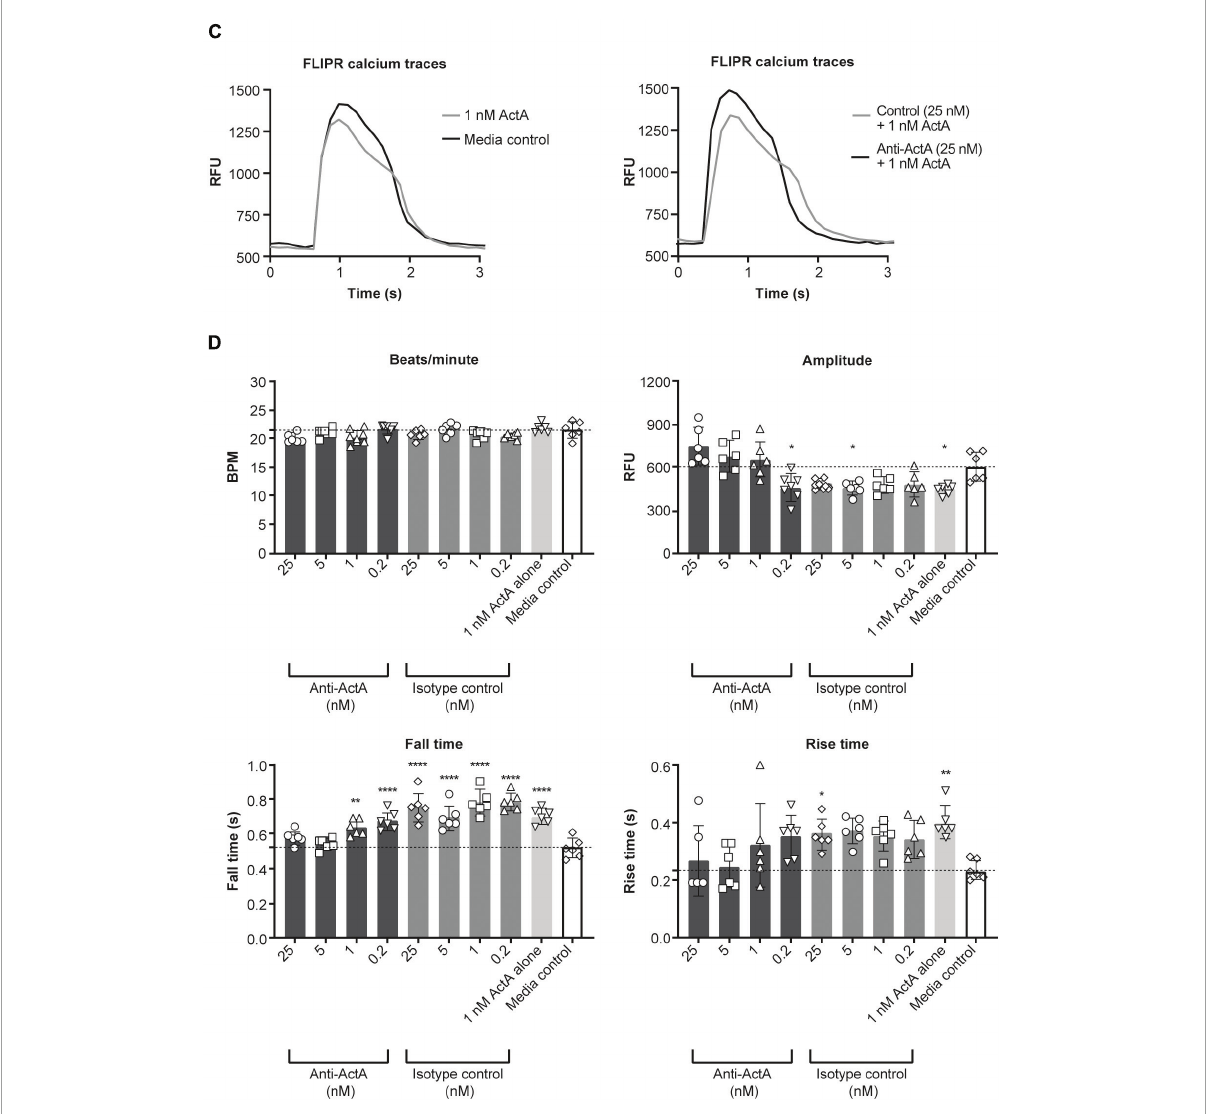
FIGURE6 Effect of Activin A on myocardial electrophysiology and calcium transients. The effect of Activin A or Activin A plus inhibitory antibody on (A,B) electrophysiology and (C,D) calcium transients in induced pluripotent stem cell–derived cardiomyocytes. One-way ANOVA was used